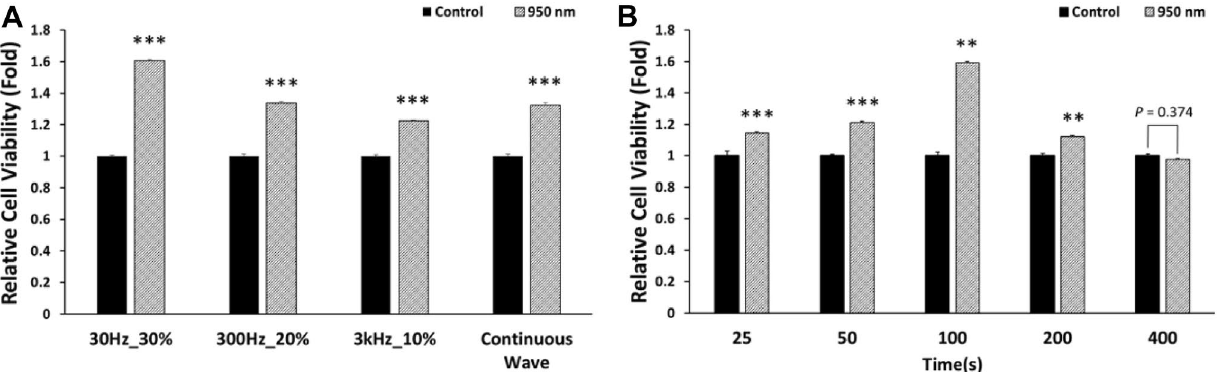
Figure 2. Optimization of 950 nm NIR irradiation conditions for cell viability. ( A ) Relative cell viability at energy density of 175.68 mJ/cm 2 . Four irradiation conditions were chosen to test a variety of frequencies, duty cycles, and decay times of DL. ( B ) Relative cell viability with different energy densities. Light with the same frequency and duty cycle, 30 Hz and 30%, was applied with different exposure times. The energy density of the 950 nm NIR irradiation for 100 s was 175.68 mJ/cm 2 . Data are mean ± standard deviation (SD) (n = 10).